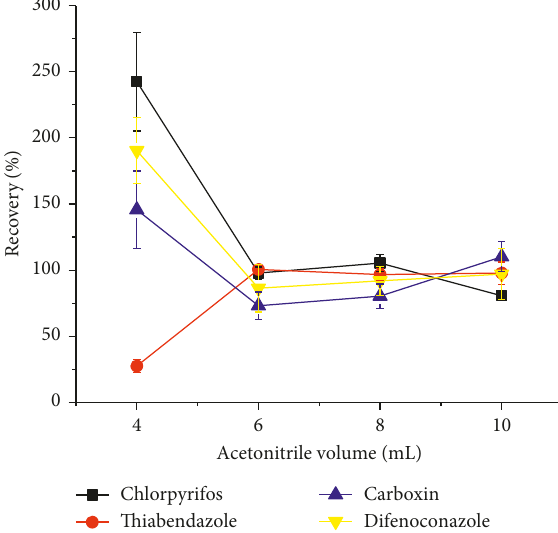
Figure 2: Pesticide residue recoveries in caj´a-manga by the SLE- LTP method using different extractor solvents.